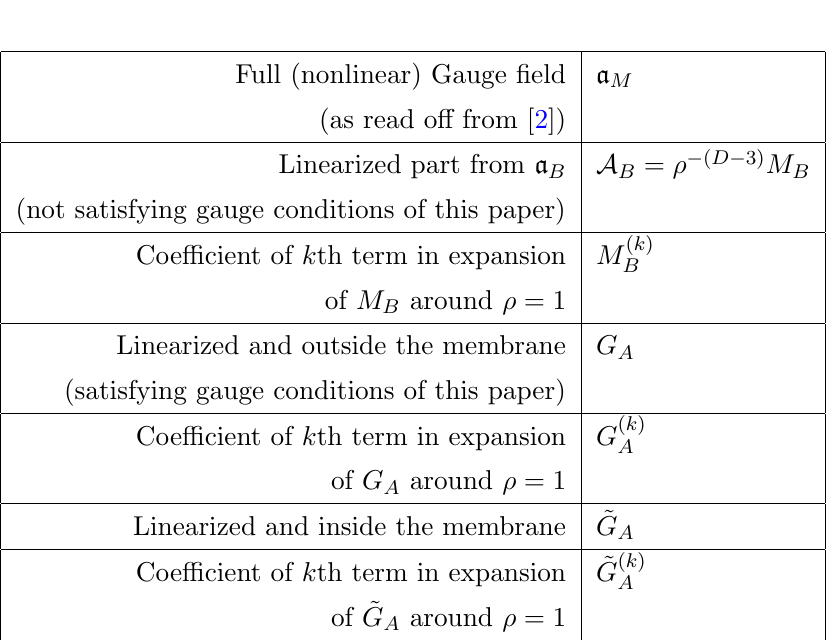
Table 2 . Di(cid:11)erent indices.